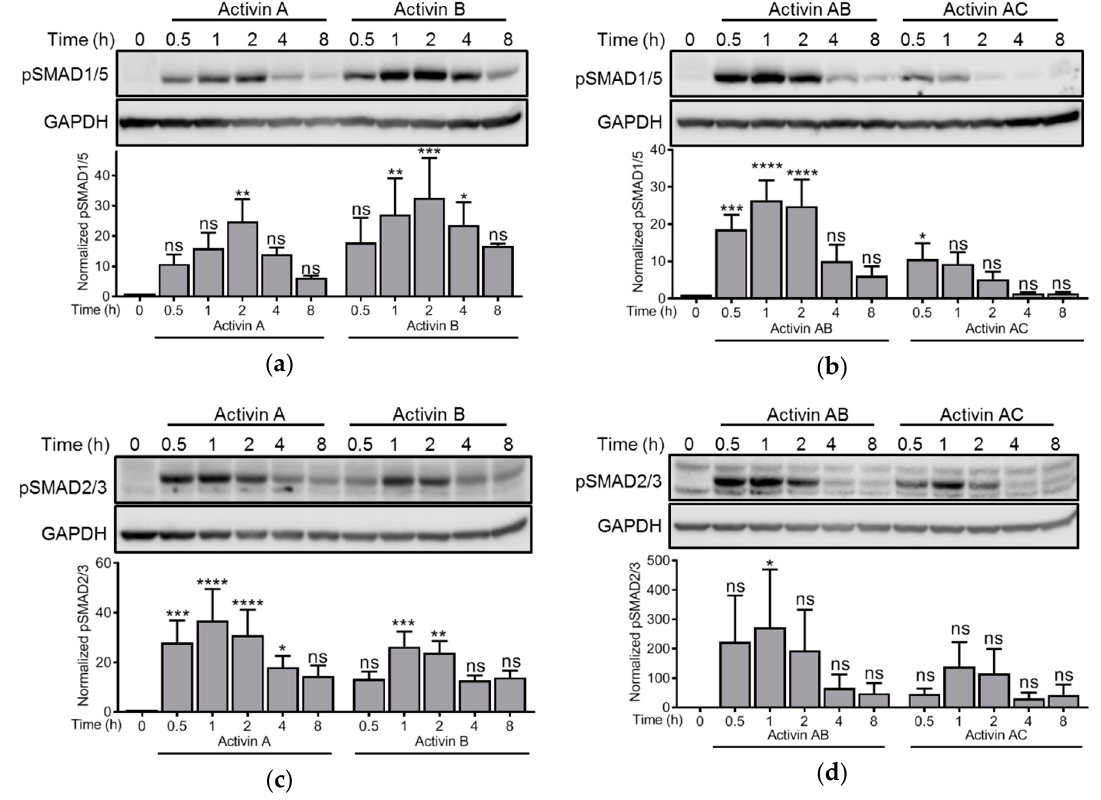
Figure 2. Time-series comparing activation of both SMAD branches by activins. IH-1 myeloma cells were treated with activin A (20 ng / mL), activin B (4 ng / mL), activin AB (5 ng / mL) or activin AC (20 ng / mL) for the indicated time-points. Then, the phosphorylation status of SMAD1 / 5 ( a , b ) or SMAD2 / 3 ( c , d ) was measured by western blot. Representative experiments are shown (upper panels) and relative activation was calculated based on signal intensities of the SMADs and GAPDH for normalization (lower panels). The graphs represent mean ± s.e.m. of n = 3 independent experiments. Two-way ANOVA and Bonferroni’s multiple comparisons test were performed (* p ≤ 0.05, ** p ≤ 0.01, *** p ≤ 0.001, **** p ≤ 0.0001, ns (not significant) p > 0.05).